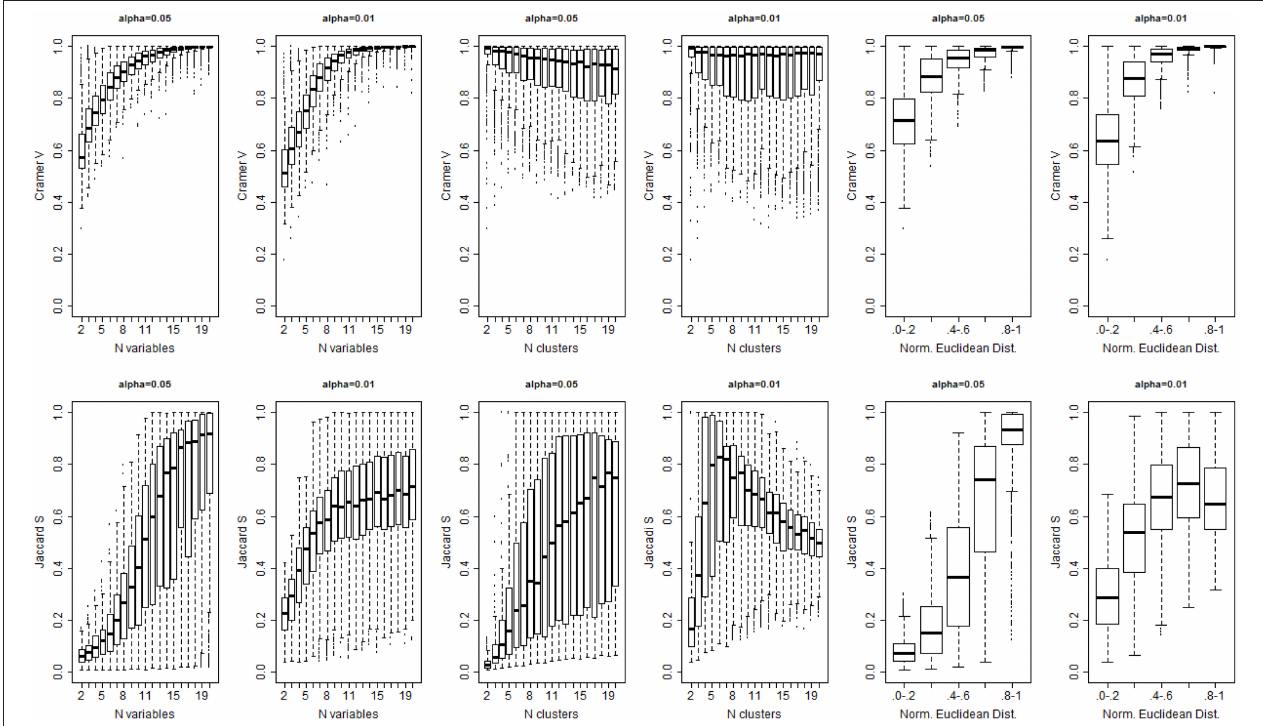
FIGURE 5 | Cramer’s Index V (top panel) and Jaccard’s Similarity Index (bottom panel) for different levels of significance α , numbers of variables (columns 1 and 2), number of true clusters (columns 3 and 4), and separation between true profiles (Norm. Euclidean